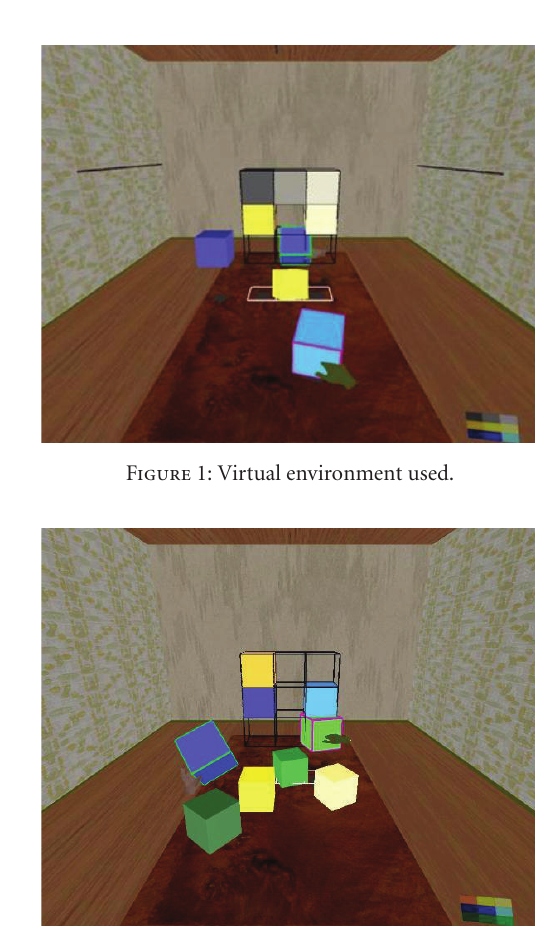
Figure 2: Screenshot of virtual hand metaphor.